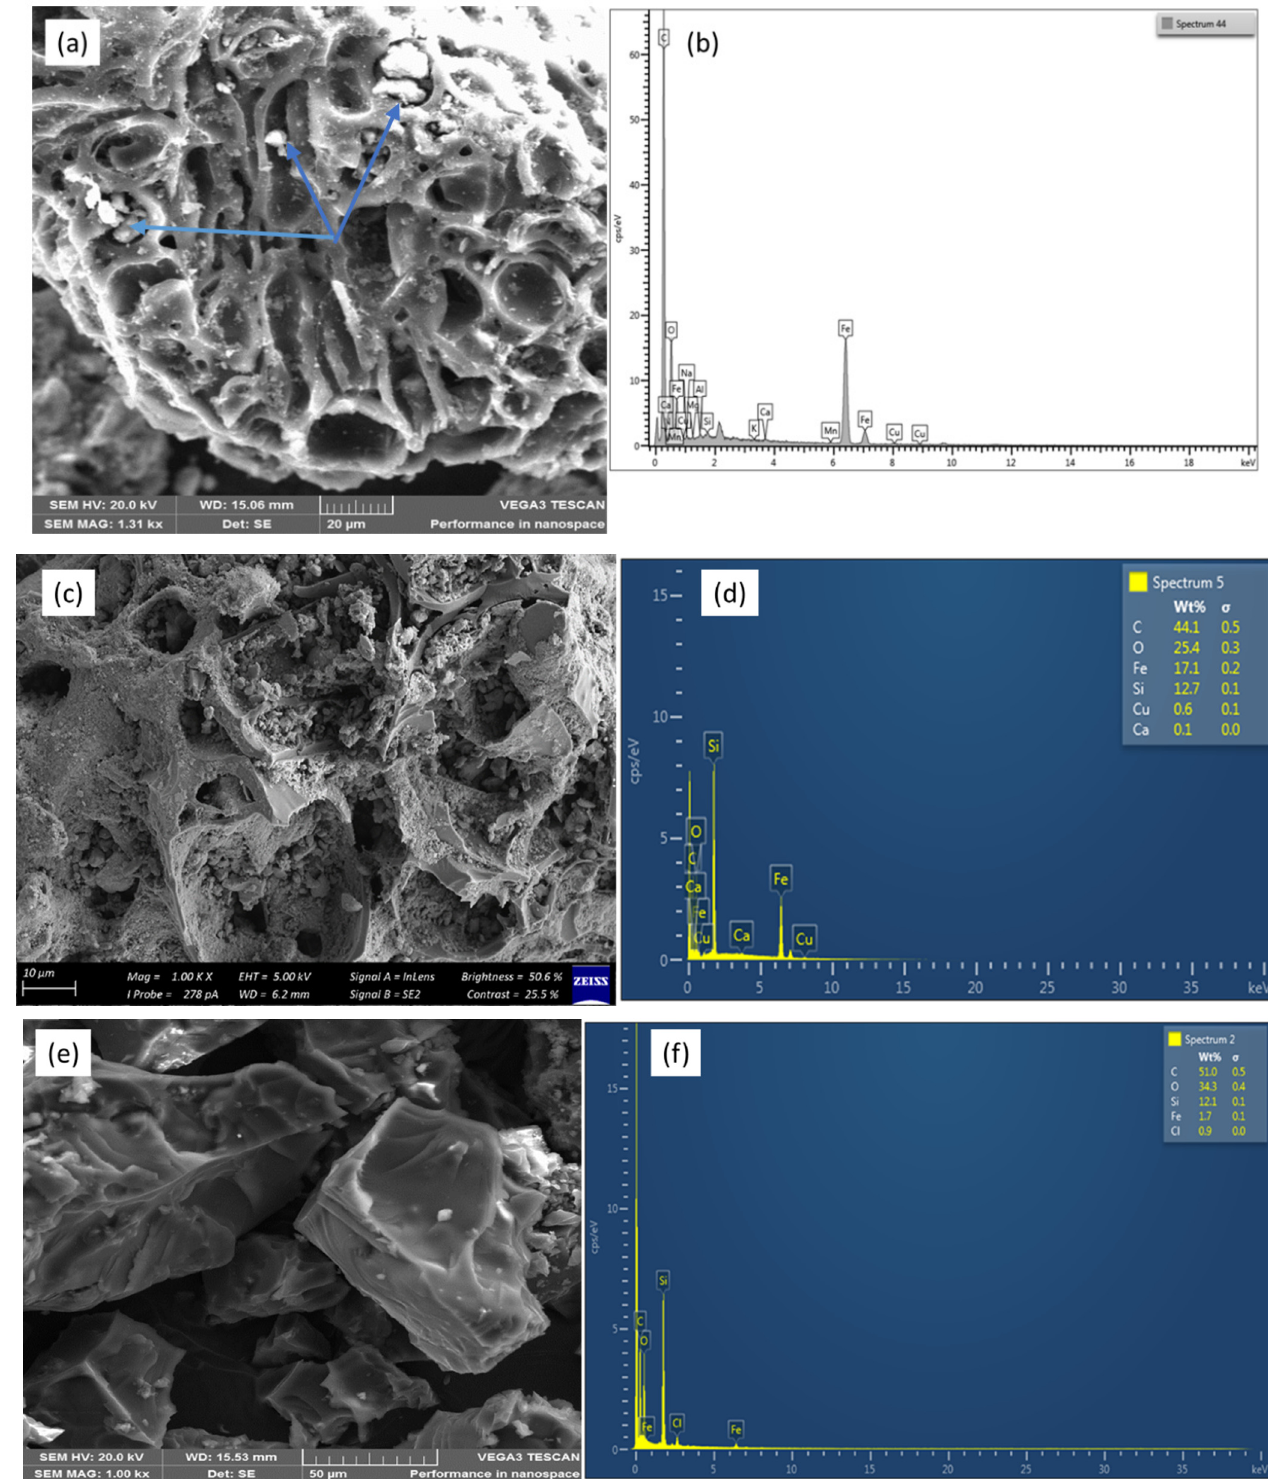
Figure 4. ( a ) SEM and ( b ) EDS of AC-Fe 3 O 4, ( c ) SEM and ( d ) EDS of AC-Fe 3 O 4 -SiO 2 : ( e ) SEM and ( f ) EDS of AC-Fe 3 O 4 -SiO 2